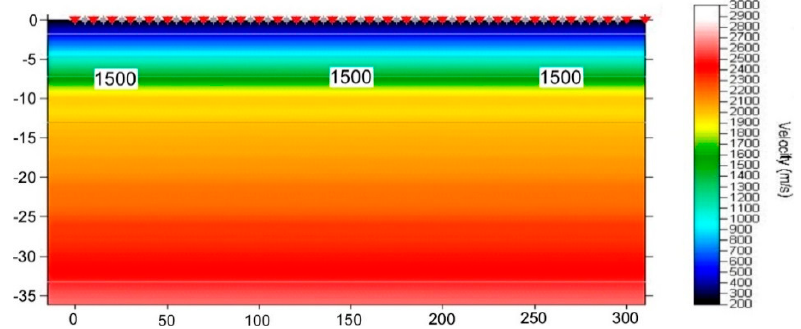
Figure 6. Initial 1-D gradient model. This model is in Surfer 8 as a base model prior to the ray-tracing feature that occurs during the tomographic processing. The x-axis represents distance along the seismic line in meters.